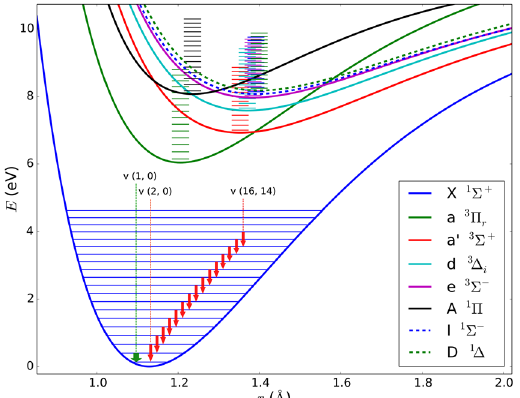
Figure 5. Potential energy surfaces for CO in several excited electronic states. The rotational-vibration transitions together with the second harmonic band transition have been observed up to vibrational level v = 16 (inside of fundamental X 1 Σ + electronic state) using infrared emission time resolved spectroscopy of electric discharge are marked in green and red